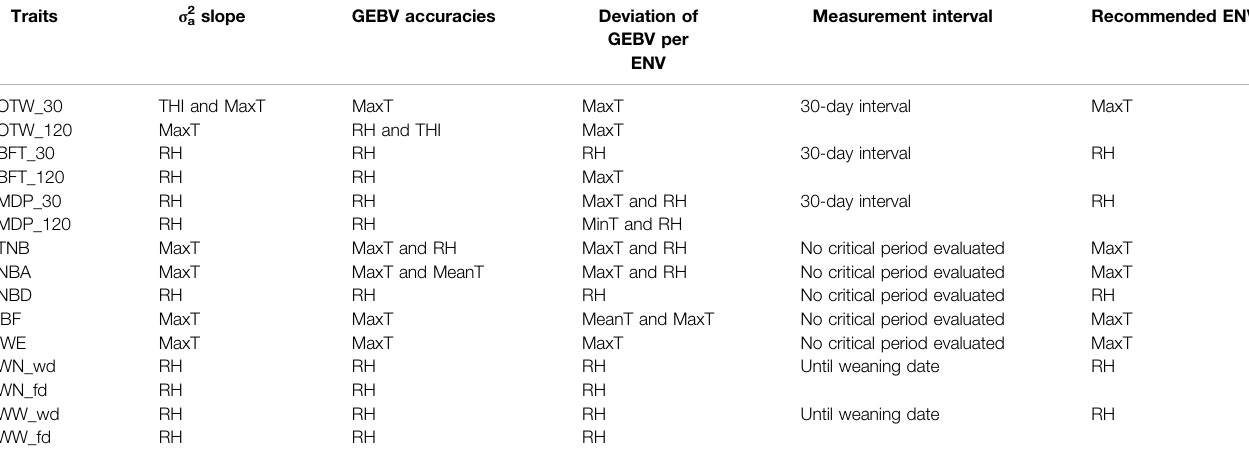
TABLE 5 | Summary and recommendation of the three criteria evaluated of each environmental variable for each trait.